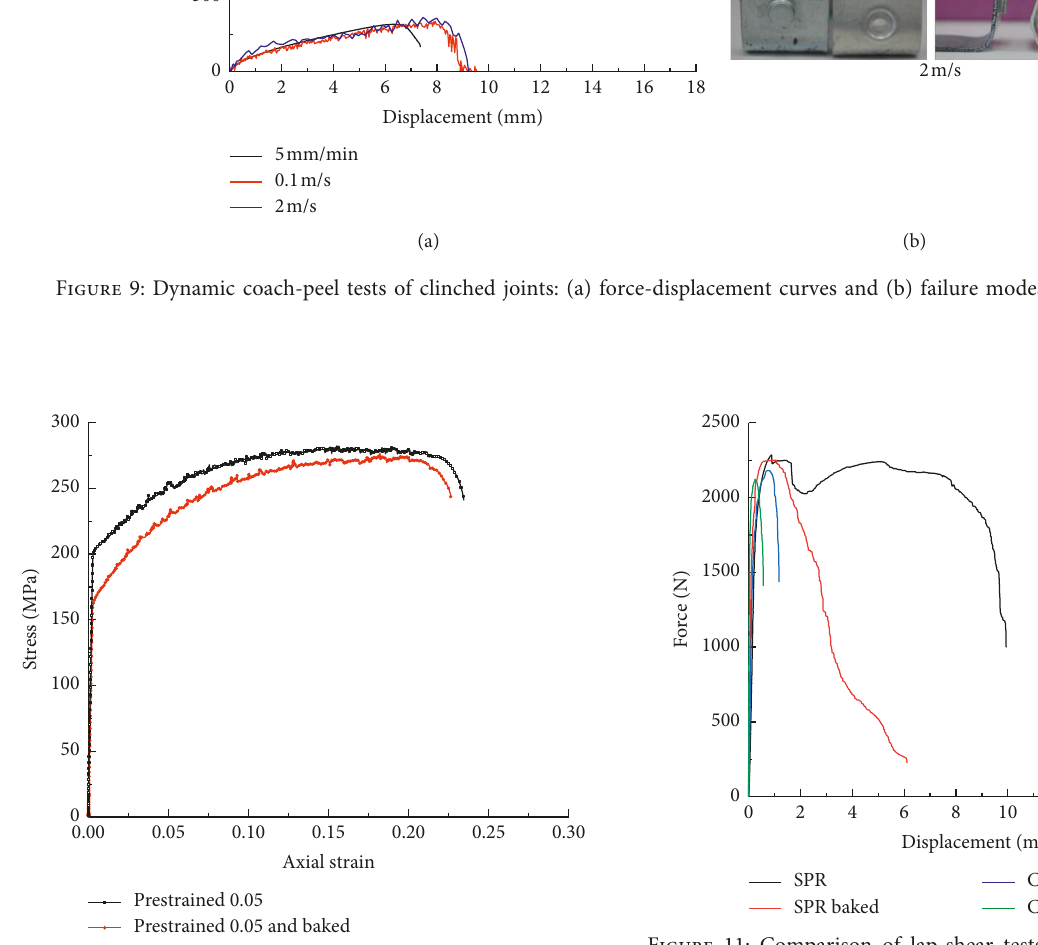
Figure 10: Quasistatic stress-strain curves of baked AA5182-O at 0.05 plastic deformation.